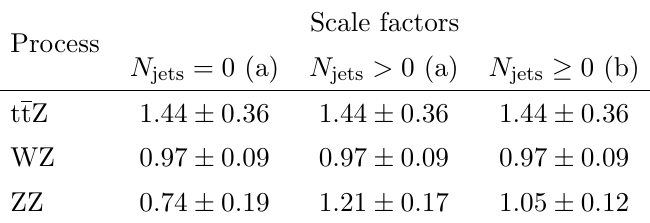
Table 4 . Summary of the normalization scale factors for ttZ, WZ, and ZZ backgrounds in the SRs used for the chargino (a) and top squark (b) searches. Uncertainties include the statistical uncertainties of data and simulated event samples, and the systematic uncertainties on the number of expected events from the residual processes in the